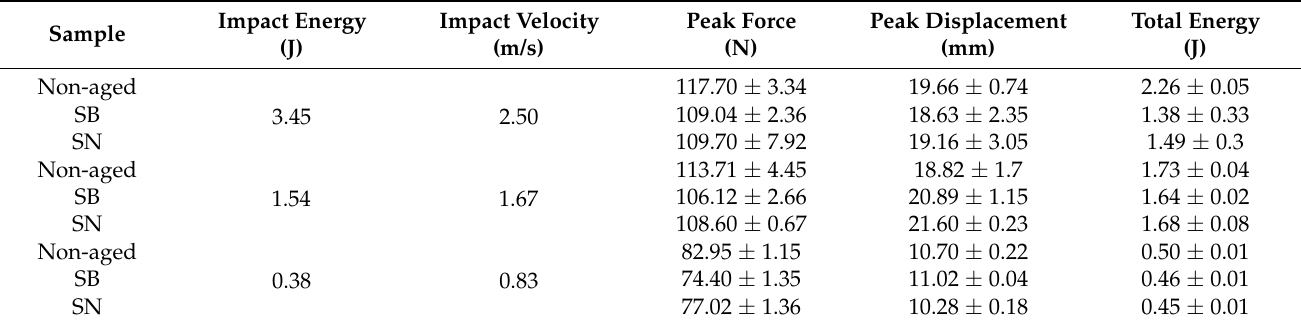
Table 6. Average values and standard deviations related to the results obtained in the impact test for Table 7. Average values and standard deviations for the three impact energies, for PFA non-aged ETFE, before and after and aged films.